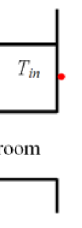
Fig. 5. Positions of T in and T out